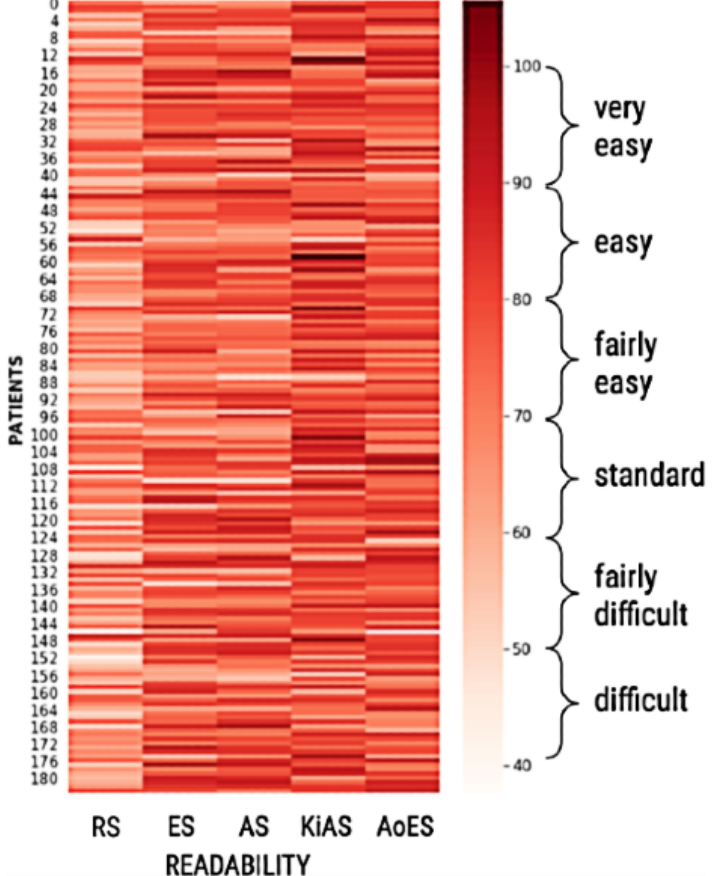
Figure 6. Heatmap of 184 patient summaries created using the Flesch Reading Ease scale. We compare the readability of summaries created from ES, AS, AoES, and KiAS with reference summaries. Darker patches indicate patient summaries, which are easy to read. AoES: abstraction over extractive summarization; AS: abstractive summarization; ES: extractive summarization; KiAS: knowledge-infused abstractive summarization; RS: reference summaries.